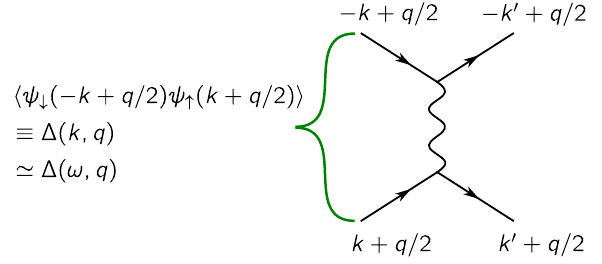
Fig. 4 Energy-momentum dependence of the pairing fi eld Δ . The brace represents the Hubbard-Stratonovich decoupling. Four- momenta k = ( ω , k ), q = ( Ω , q ) are used. We always neglect the dependence of Δ on the relative momentum of a Cooper pair, k